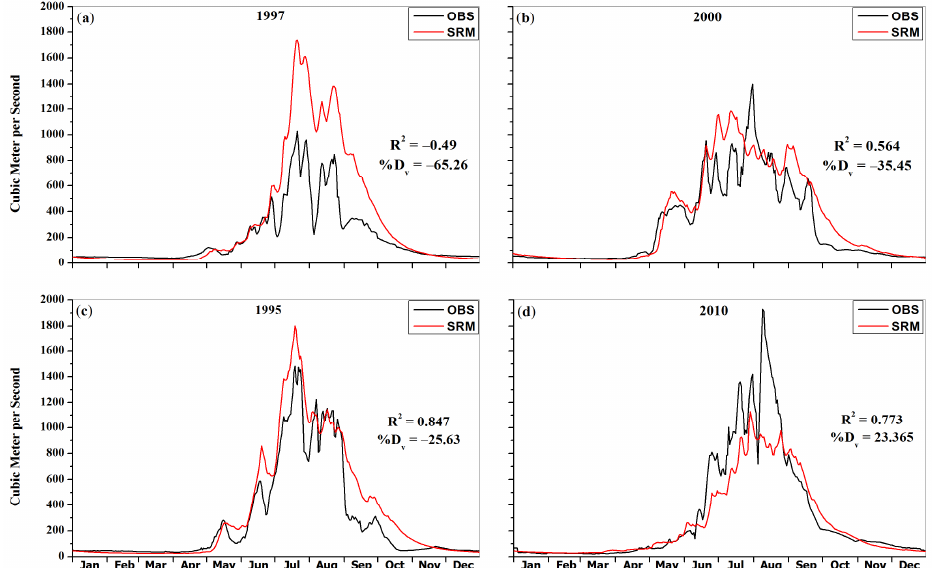
Figure 10. ( a – d ): Inconsistent simulations by SRM for years 1995, 1997, 2000, and